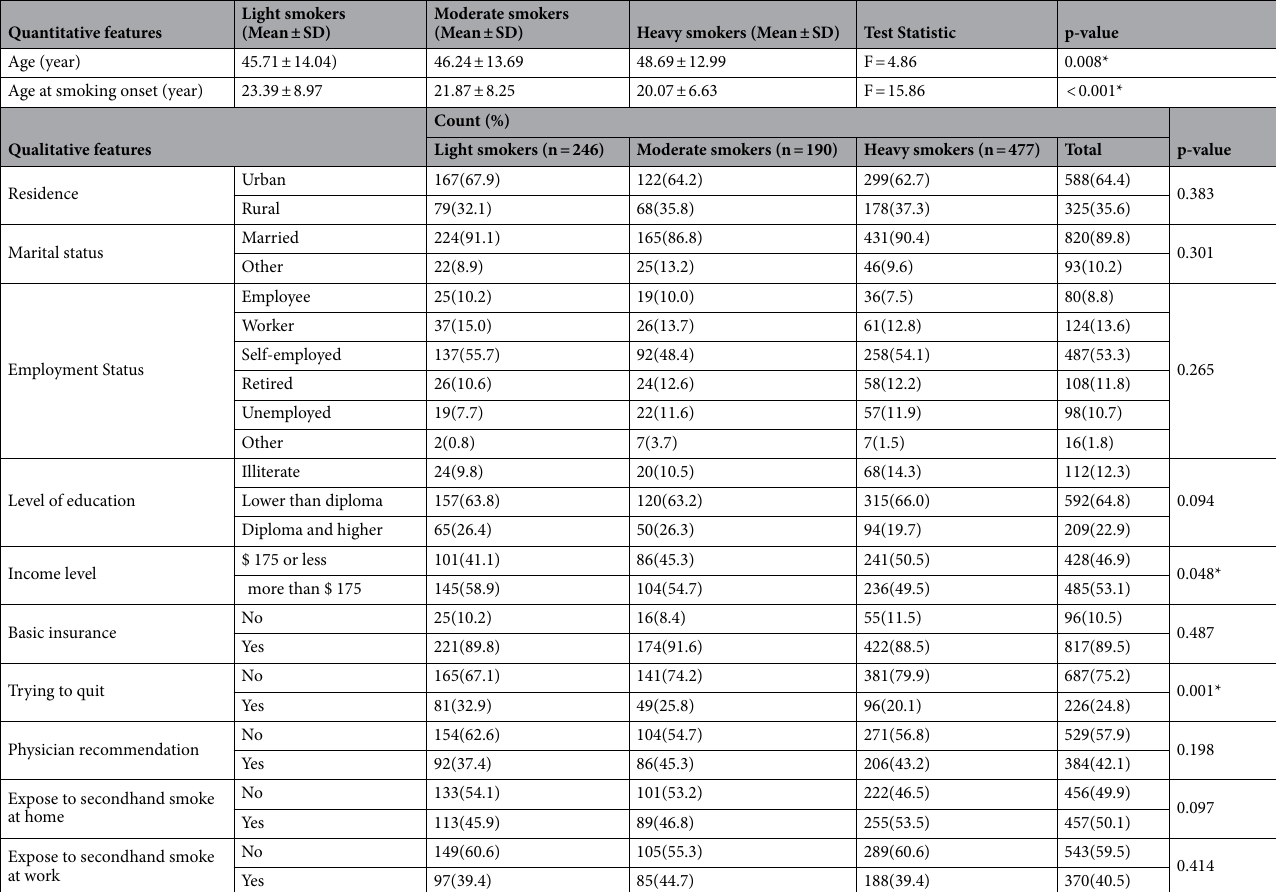
Table 1. Demographical feature and status. *Significant test in level